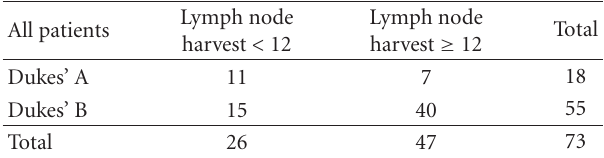
Table 1: Relation of number of lymph node harvested to Duke’s Stage.